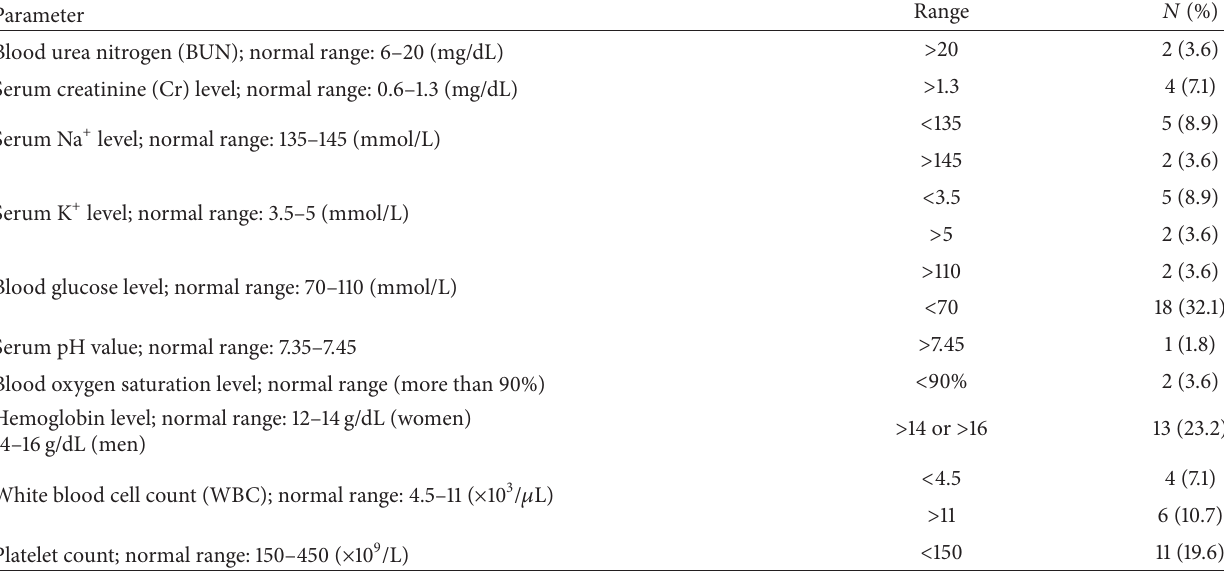
Table 3: Frequency distribution of paraclinical tests in the studied patients.